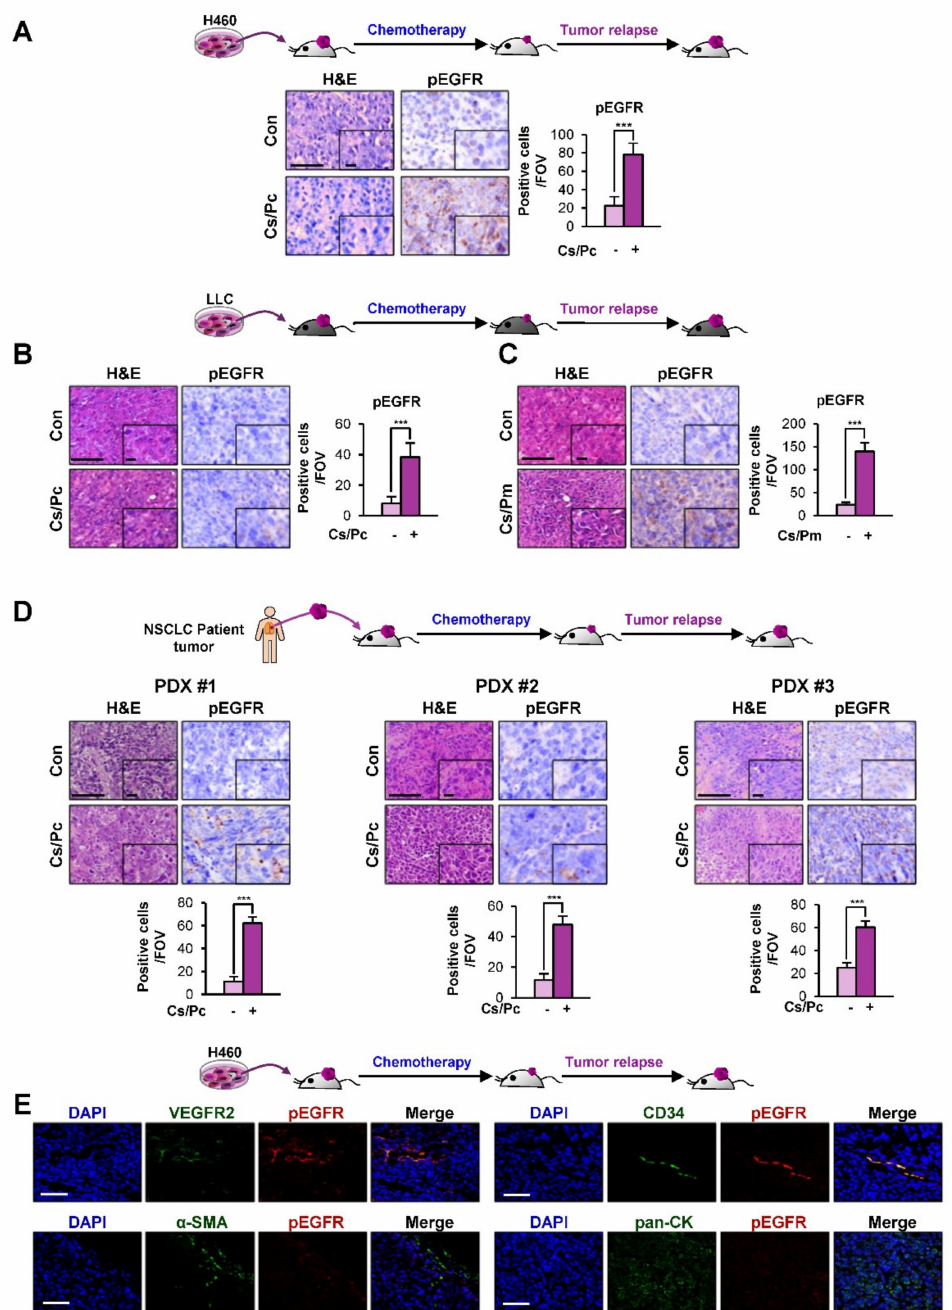
Figure 3. Increased expression of phosphorylated epidermal growth factor receptor (EGFR) in tumors derived from those that relapsed after chemotherapy in vivo. ( A–D ) IHC analyses to assess the activation of EGFR [phosphorylated EGFR (pEGFR; phosphorylation at Y1068-positive)] in H460 xenograft tumors ( A ), Lewis lung carcinoma (LLC) allograft tumors ( B, C ), and PDX tumors ( D ) that relapsed after chemotherapy. Quantification of cells positive for each marker per field of view (FOV, n = 12 from at least three tumors) is depicted as a graph. ( E) Elevation of pEGFR expression in VEGFR2 + endothelial cells or CD34 + EPCs in H460 xenograft tumors that relapsed after chemotherapy (Cs / Pc) was determined by a double IF analysis. Scale bar: 50 µ m ( A–E ). Scale bar (inset): 10 µ m ( A–D ). For all panels, the bars represent the mean ± SD. *** p < 0.001, as determined by two-tailed Student’s t